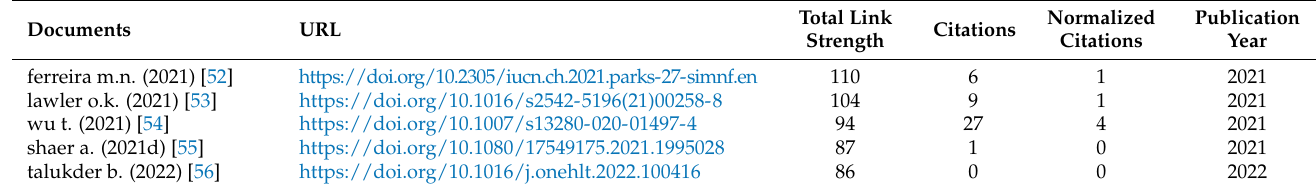
Table 3. Top 20 documents with the greatest total link strength found using bibliographic data and bibliographic coupling links for the topics “COVID-19” and “land use”, applying full counting with 0 as the minimum number of citations of a